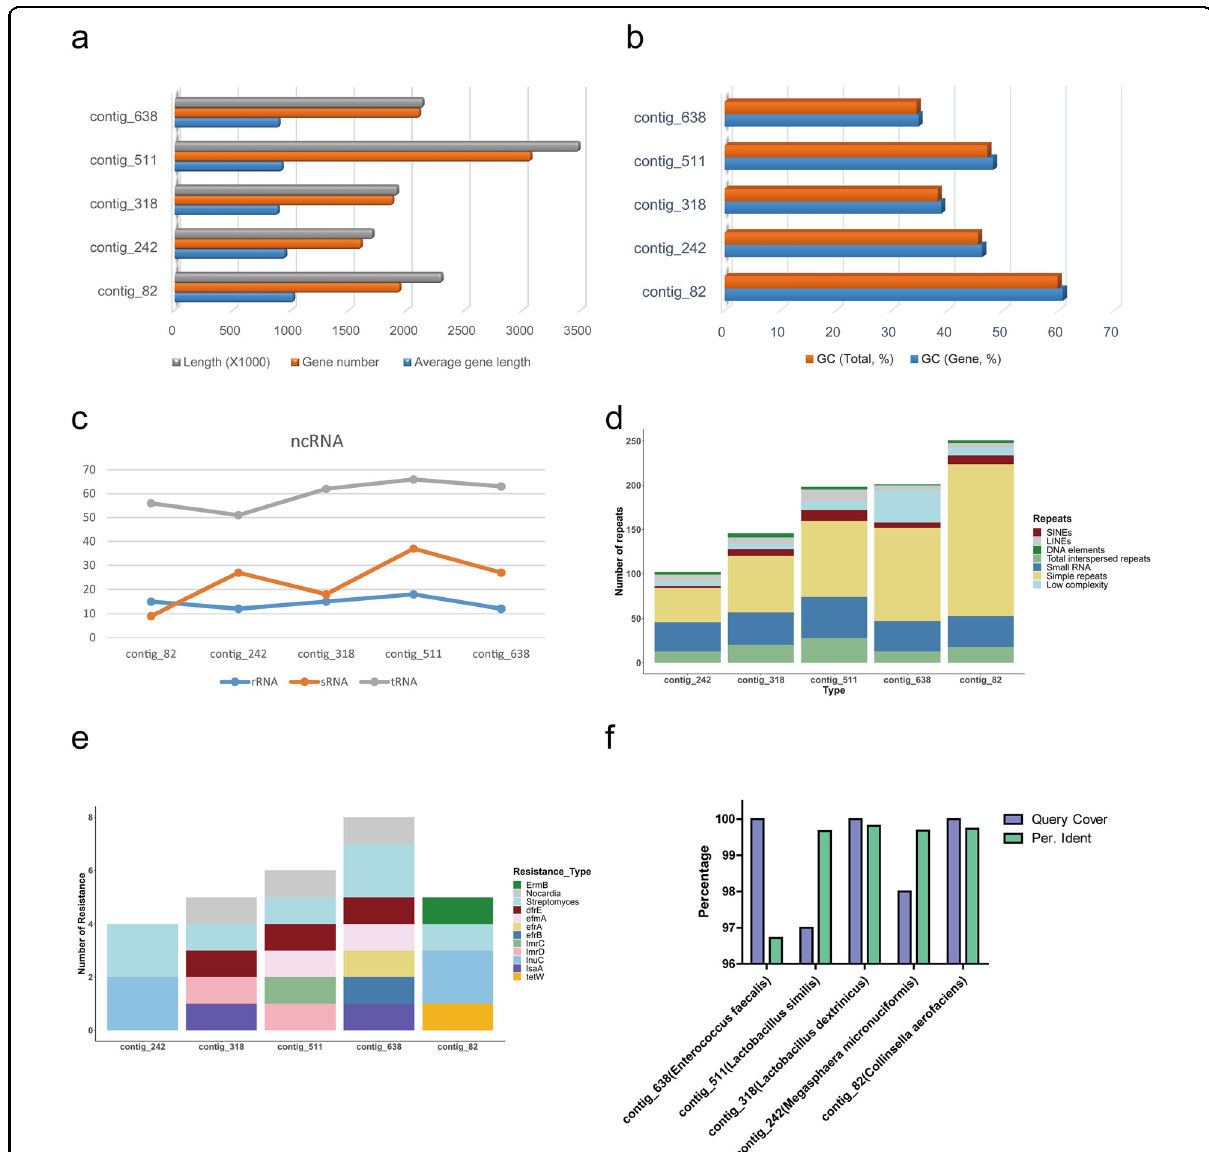
Fig. 3 The genome analysis of the fi ve non-match genomes. a The genome length and gene number of the fi ve non-match genomes. b The GC content(total and gene) of the contigs in the two samples of the fi ve genomes. c The ncRNA analysis (rRNA, tRNA and sRNA) of the fi ve genomes. d The repeat sequences of the fi ve genomes. e The antibiotic potential of the fi ve genomes. f The blasted result of the full-length 16S rRNAs of the fi ve sequences in the NCBI database. The reference bacteria are shown in